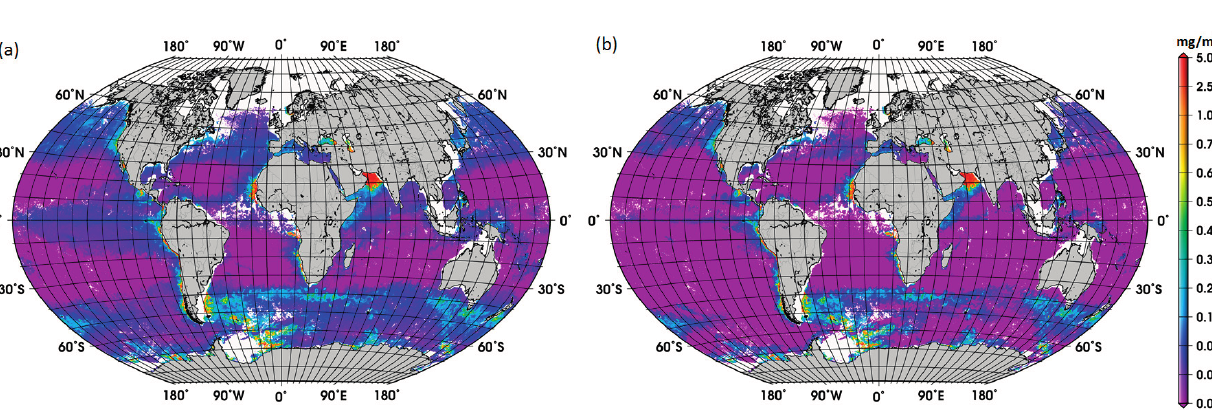
Figure 3. Monthly mean TChla (mg/m 3 ) of diatoms for February 2003 using the Zpd ABA model parameterized with: ( a ) Global data set (average = 0.060 mg/m 3 ) and Zpd ( b ) global data set excluding SO data (average = 0.041 mg/m 3 ). White areas correspond to waters with depths shallower than 200 m or without satellite